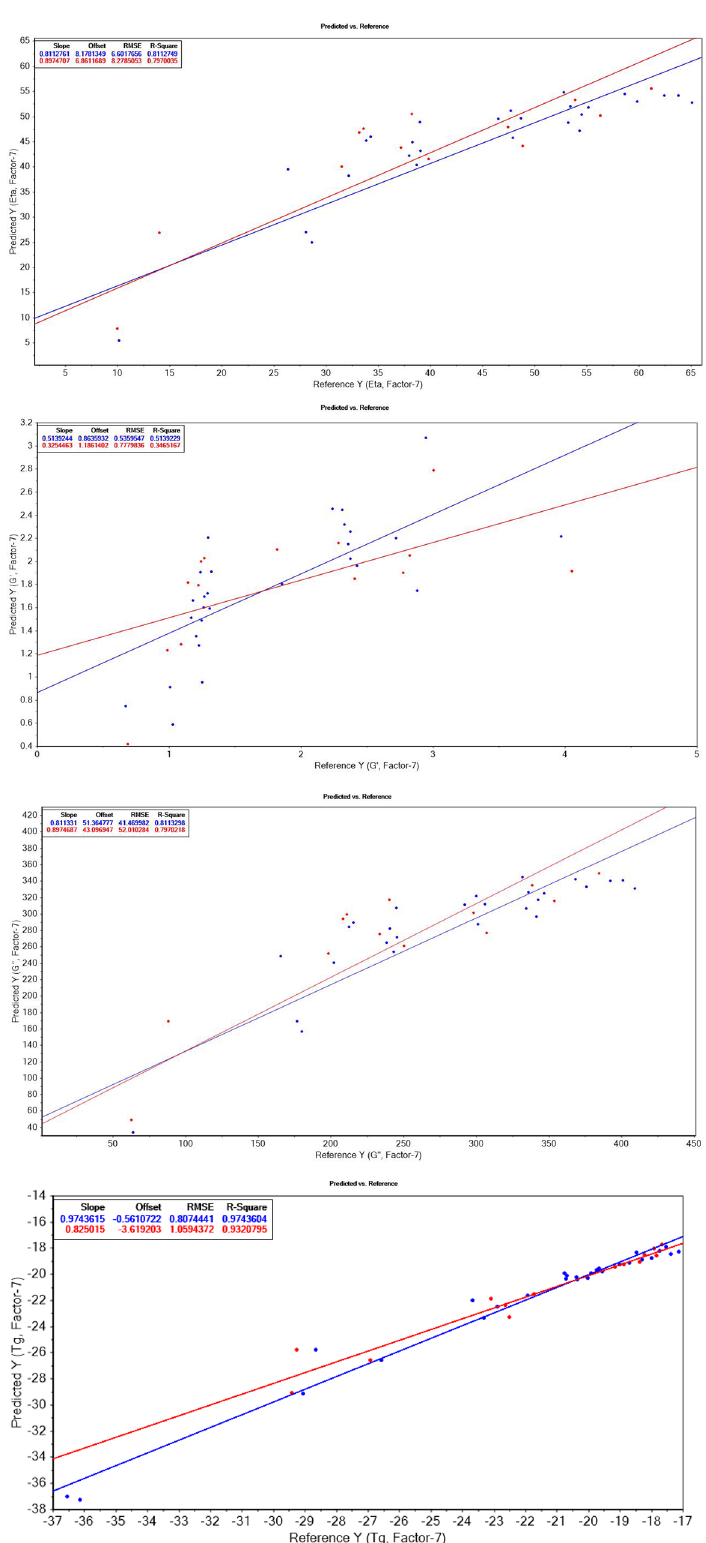
Figure 4. PLS-R model for the prediction of rheological parameters (dynamic viscosity (eta), G ʹ and G ʺ ) and T g : experimental vs predicted